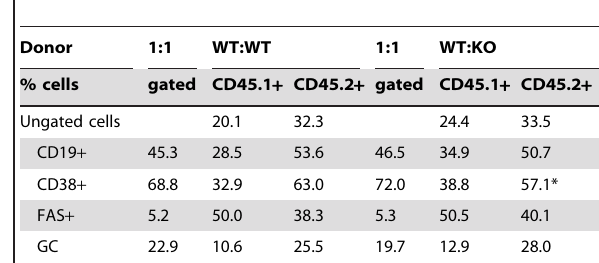
Table 6. FACS analysis of the B cell populations present in the Peyer’s patches three months after competitive bone marrow